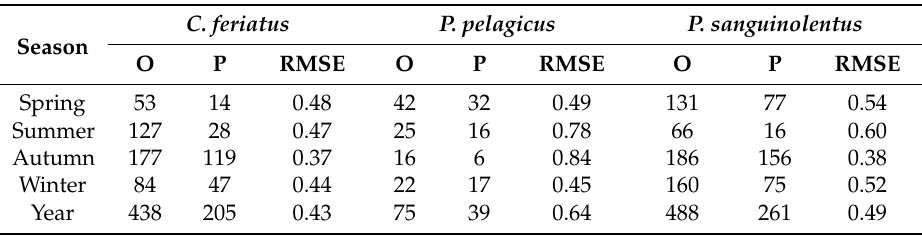
Table 2. Numbers ( > 60%) of observed (O) and predicted (P) high catch rates of C. feriatus , P. pelagicus, and P. sanguinolentus in the TS in 2016. The RMSE represented the test error metric of cumulative frequency